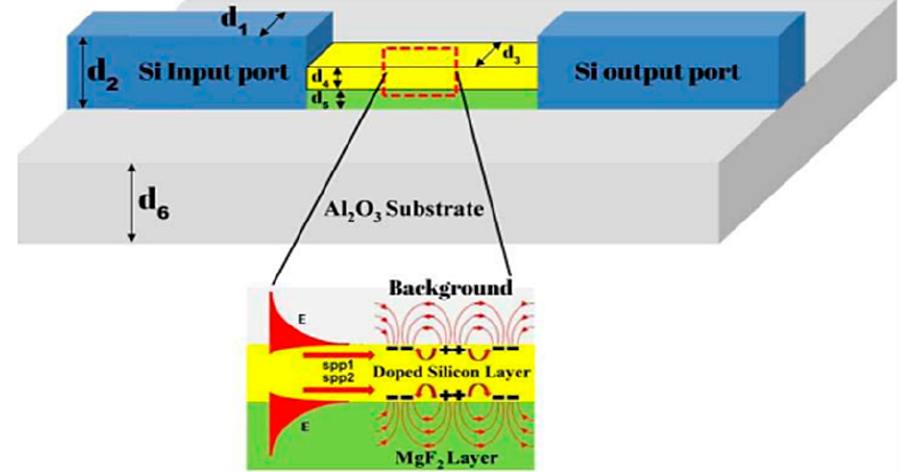
Figure 18. Schematic diagram of the 3D-design of the plasmonic MZI, d 1 = d 3 = 1.4 µ m, d 2 = 0.8 µ m, and d 6 = 1 µ m. The insertion shows the electric field distribution on the insulator-metal-insulator interface. It also demonstrates the electric field exponential decay across the doped-silicon depth along with the propagating path as shown by the exponential curve. As for the background, it refers to the sensing arm. Reprinted with permission from Ref.